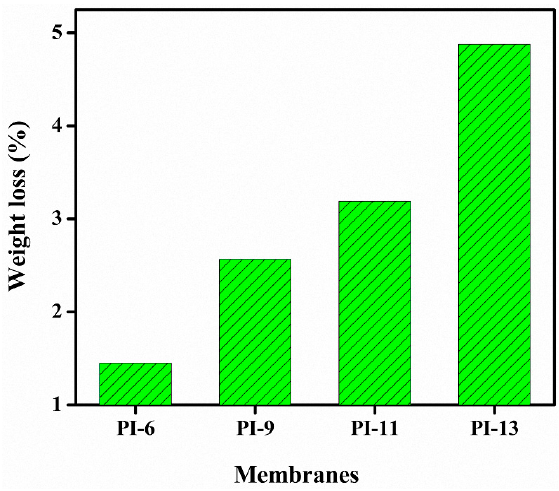
Figure 4. Chemical stability of AEMs with increasing amounts of PI during 72 h in 2 M HCl solution. Table 3. Variation (wt %) in the chemical stability tests calculated by function of the residual Br − content after washing with water and by the function of the PI content.